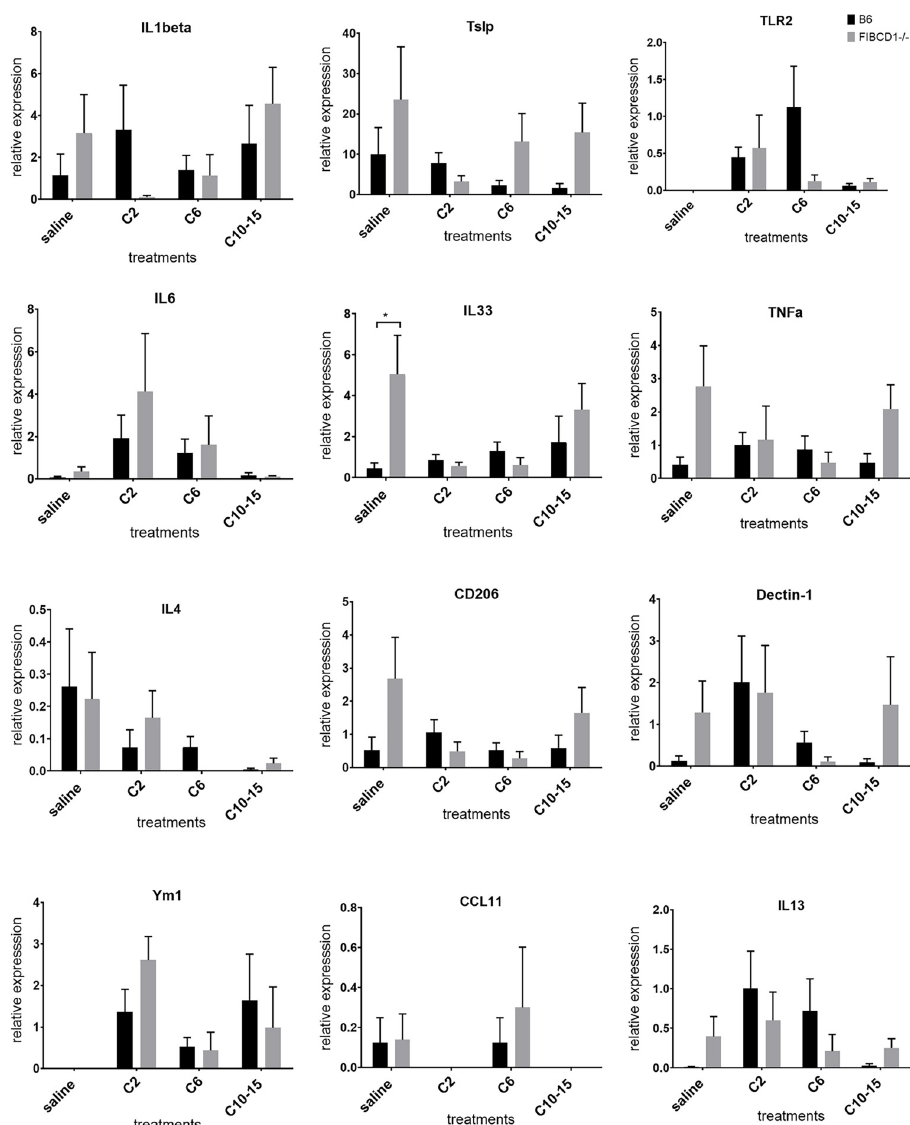
Fig 3. Cytokine modulation in vivo due to FIBCD1 in response to chitin fragments of different sizes. Mice were challenged with chitin fragments (as described in materials and methods) and analyzed by qRT-PCR for expression of indicated cytokines using ΔΔ Ct method. Data are a summary of two experiments. n = 8/group. � p < 0.05.